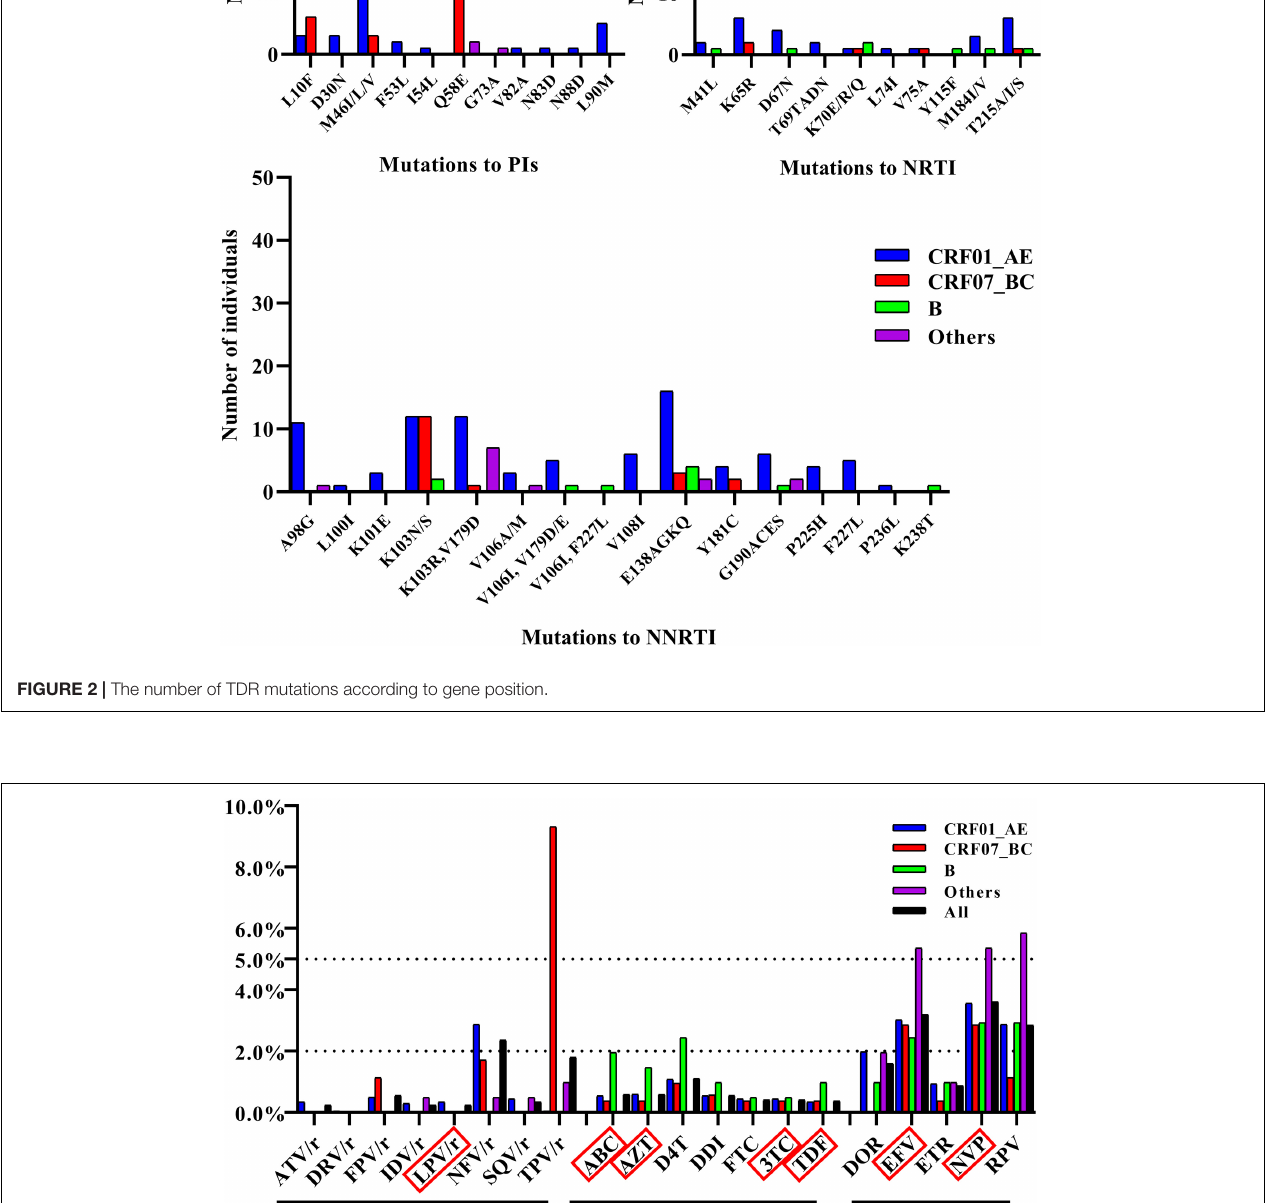
Frontiers in Microbiology |